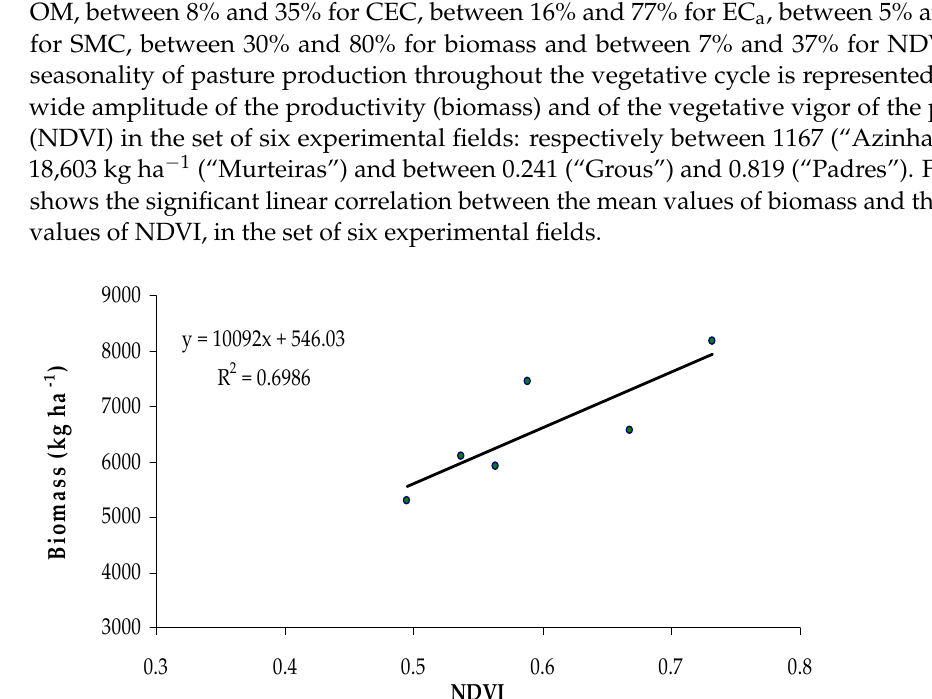
Figure 5. Linear correlation between mean pasture productivity (biomass) and mean pasture vegetative vigor (NDVI) in the set of six experimental fields used in this study.